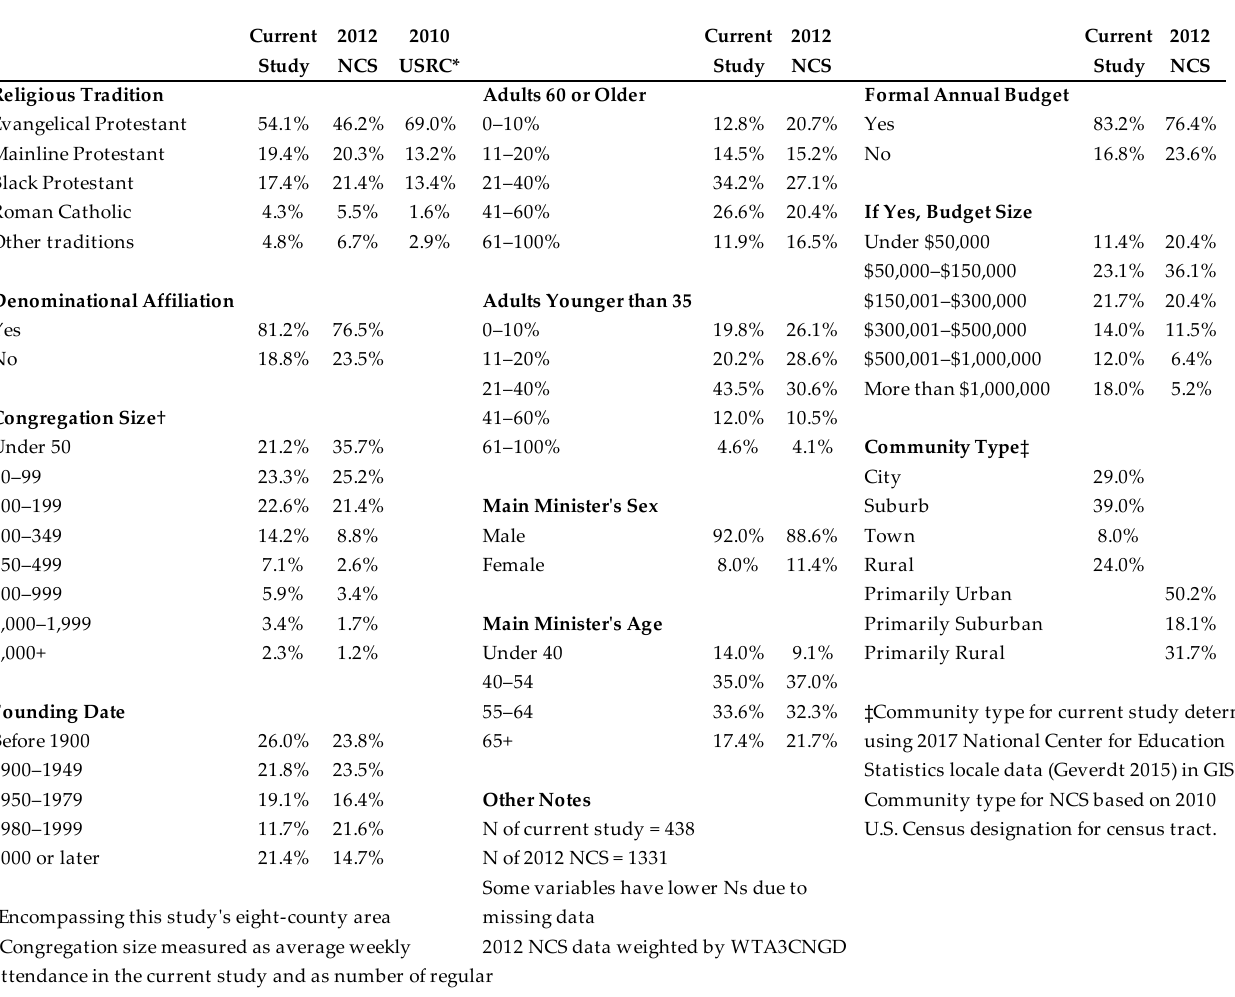
Figure A1. Comparing Current Study to the 2012 National Congregations Study and the 2010 U.S. Religion Census. Source: